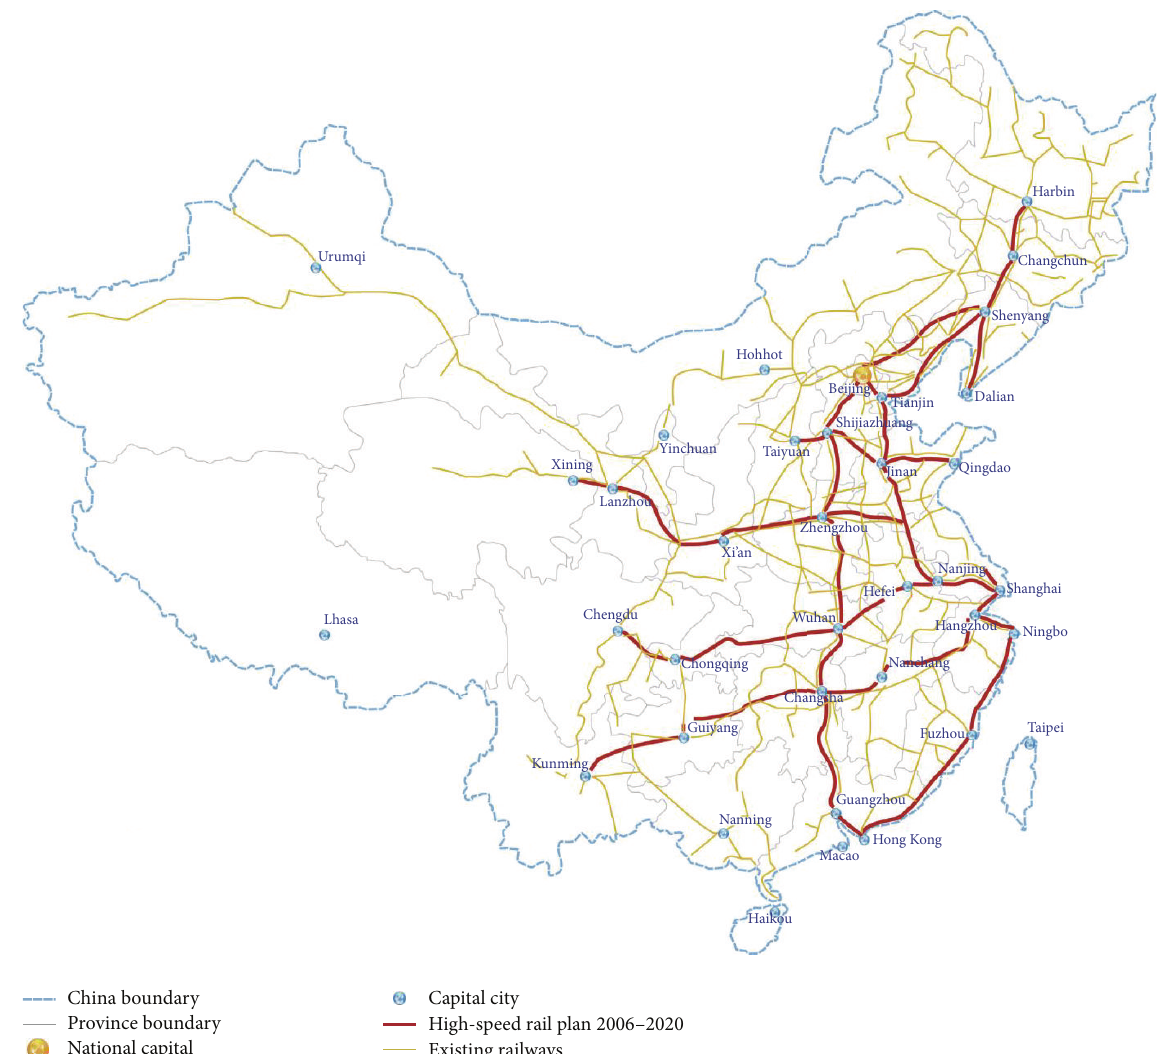
Figure 1: Plan of China HSR program in